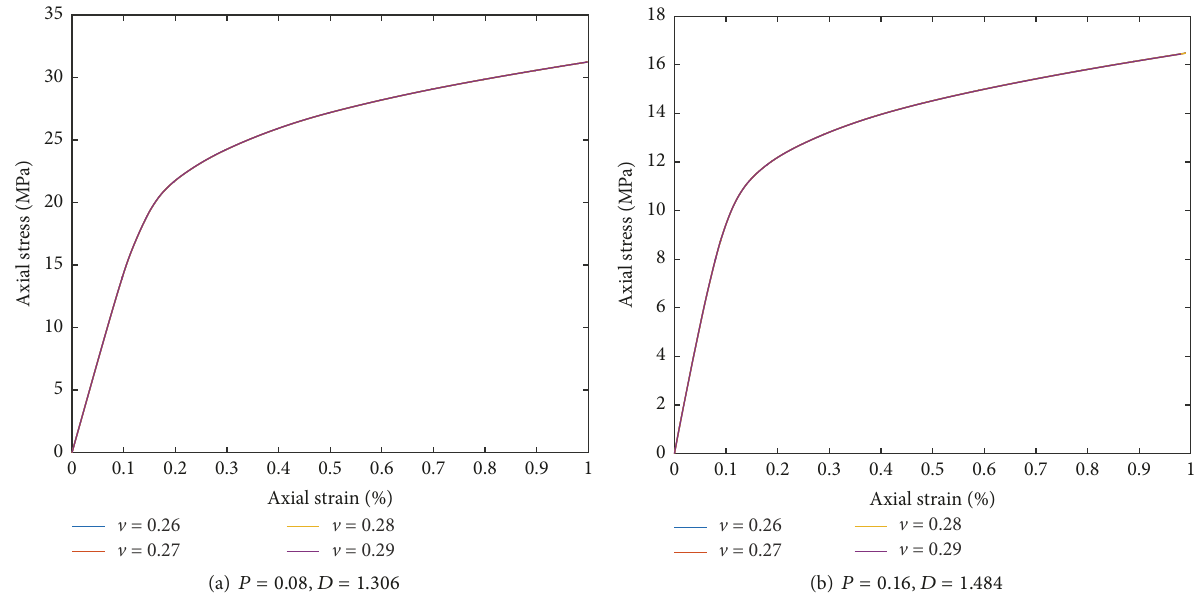
Figure 10: The stress and strain curves with the porosity and fractal dimension consistent with the variation of Poisson’s ratio of the matrix.